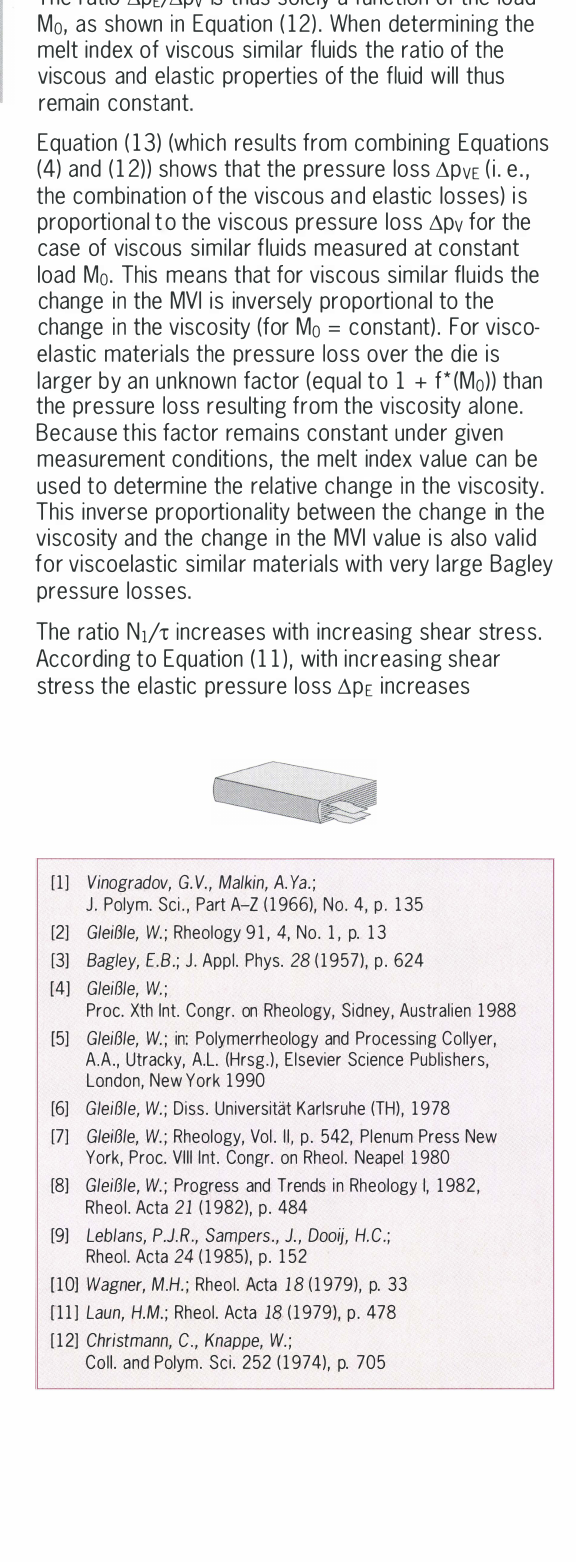
Fig. 11: Shear stress and first normal stress difference of Plexiglas melts BH, lN and 5N as a function of the reduced shear